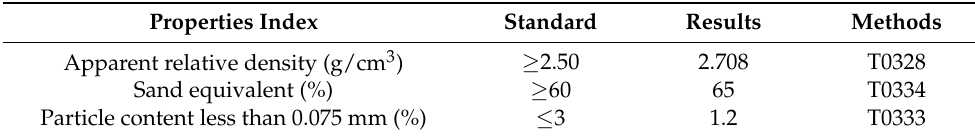
Table 4. Technical indicators of thin aggregate.